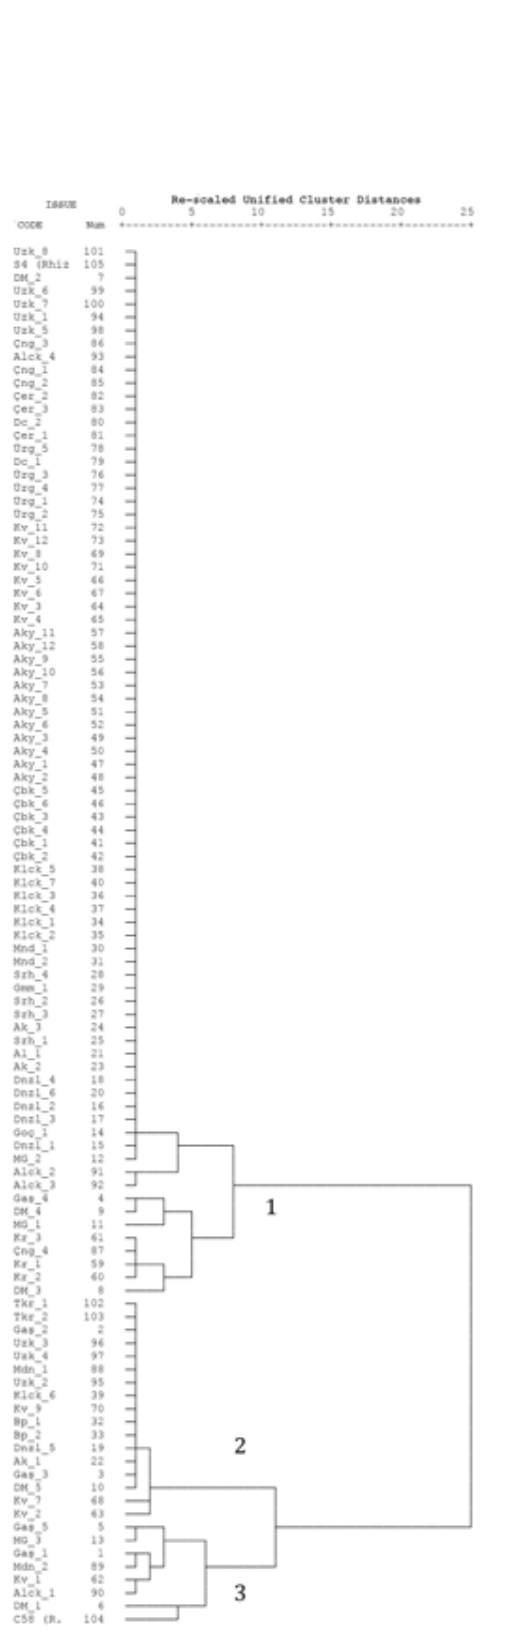
Figure 2. SPSS cluster analysis of Rhizobium vitis strains based on phenotypic and physiological test results.